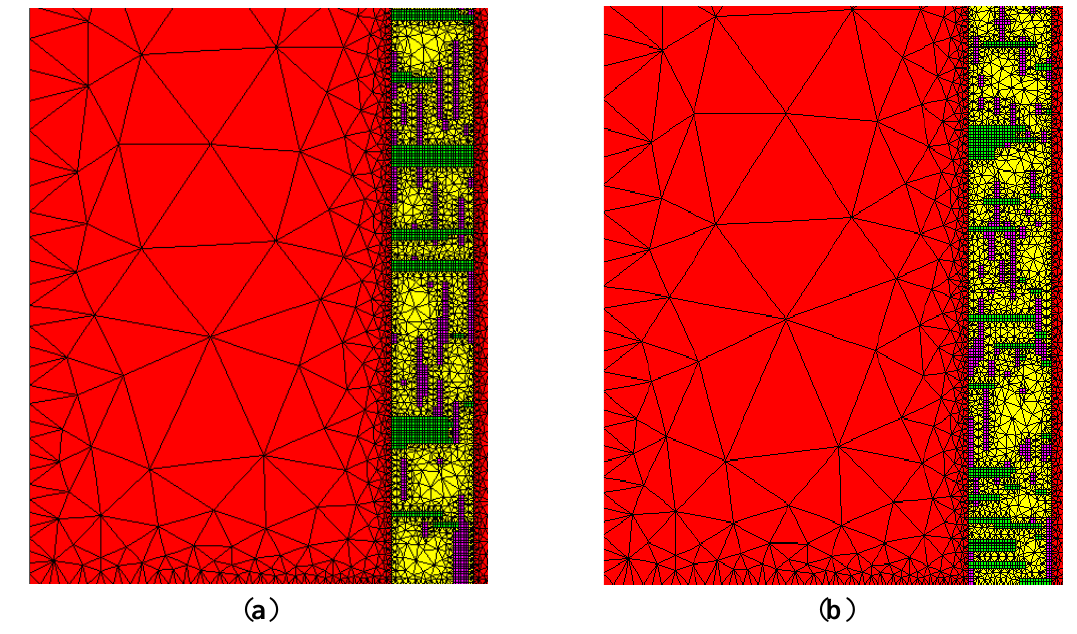
Figure 4. Partial views of two different representative volume elements (RVEs) and internal and external border meshes of effective modeling of NF network reinforcing matrix. ( a ) RVE with long NFs; ( b ) RVE with short NFs. Red = CFs, yellow = matrix, green = radial NFs, purple = longitudinal